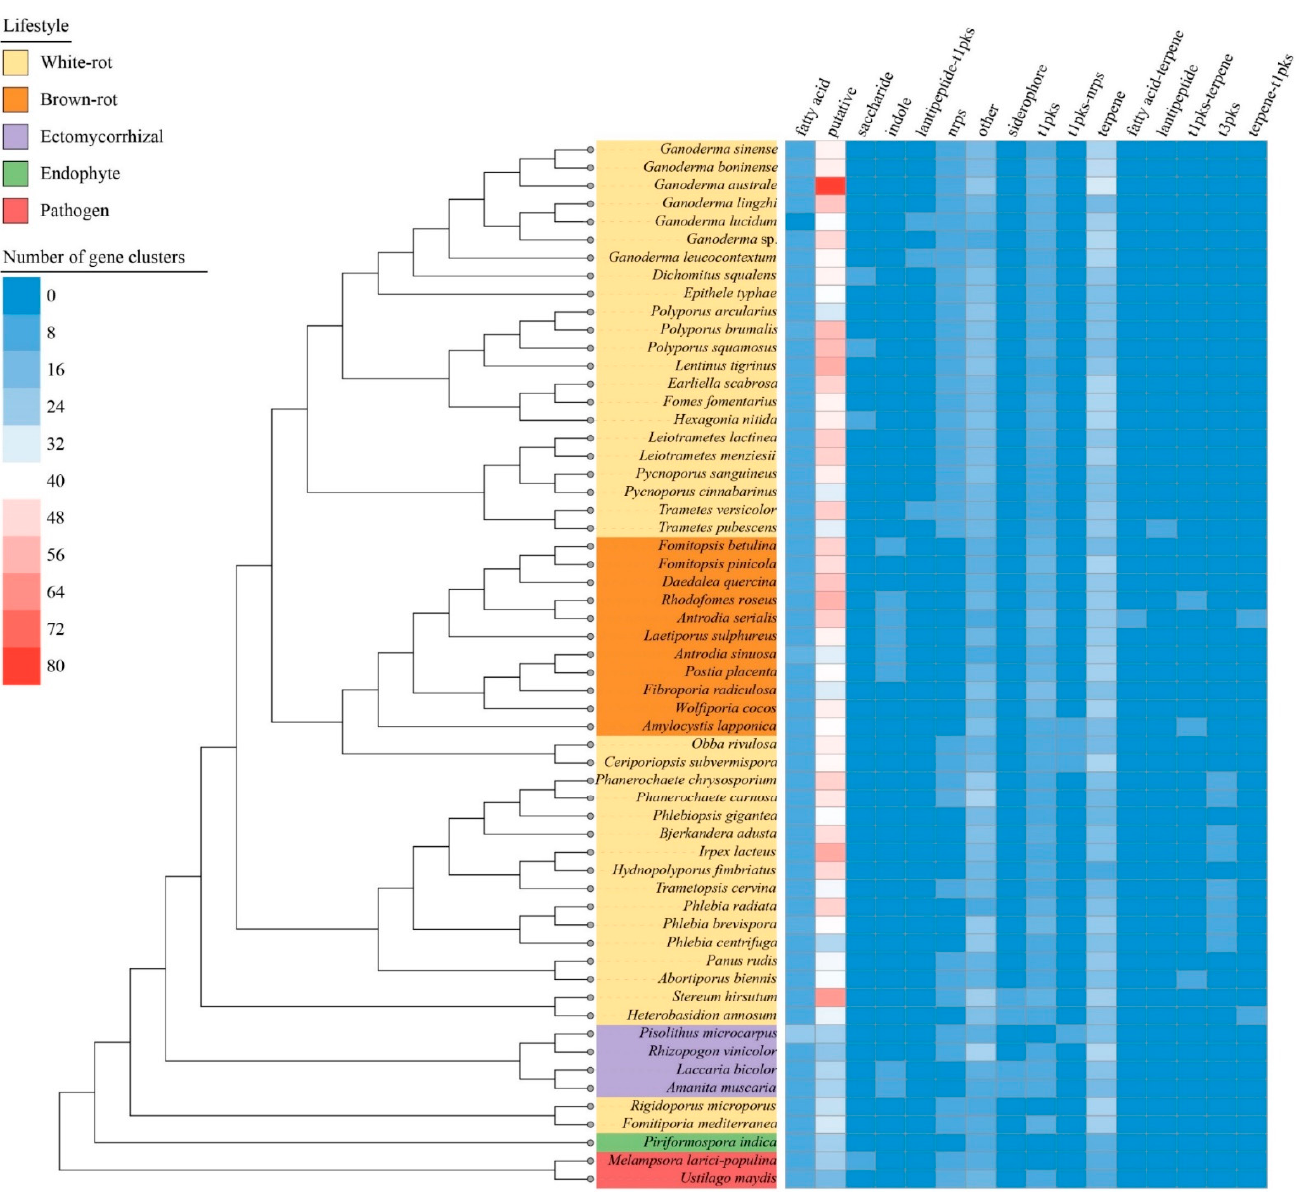
Figure 5. Presence and abundance of the gene clusters involved in secondary metabolite biosynthesis along with the species phylogenetic relationship between the 58 selected fungal species. The heatmap depicts the number of the gene clusters according to the color scale from blue to red. Color codes for the five fungal lifestyles are shown at the top left of the figure.